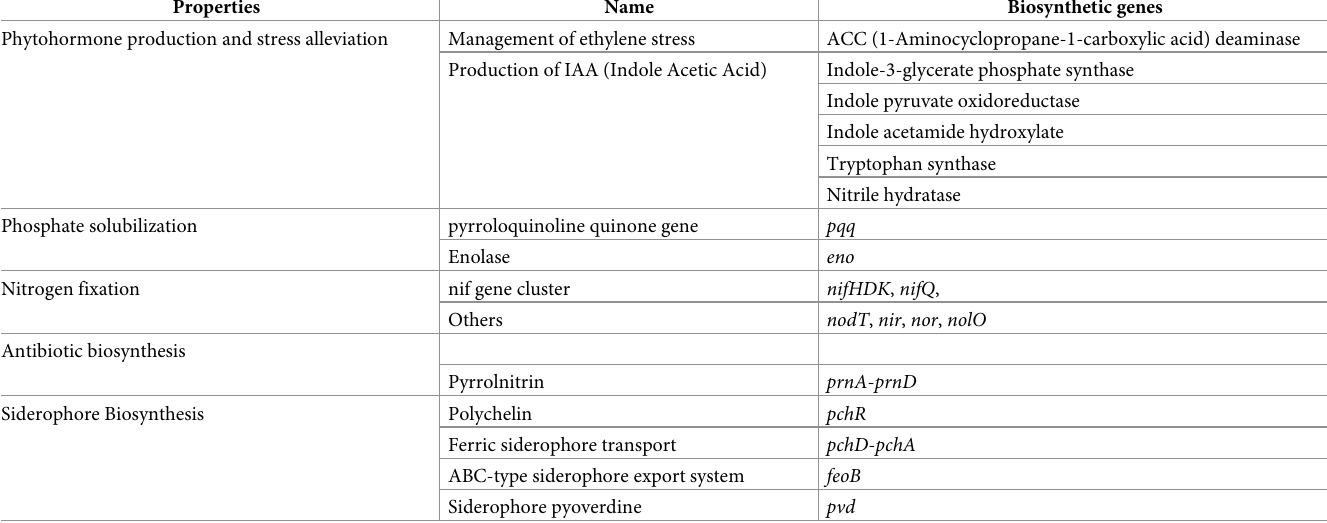
ase system (PTS), and major facilitator superfamily (MFS) transporter genes. In silico analysis using RAST also revealed the presence of genes for indoleacetamide hydrolase involved in IAA Table 1. List of genes involved in plant growth promotion activity detected from RAST, antiSMASH, PIFAR analysis of the B . contaminans NZ whole genome.